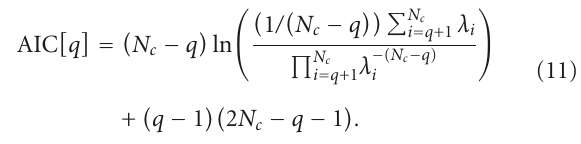
Figure 3: Algorithm flowchart for the ISAR focusing technique based on superresolution